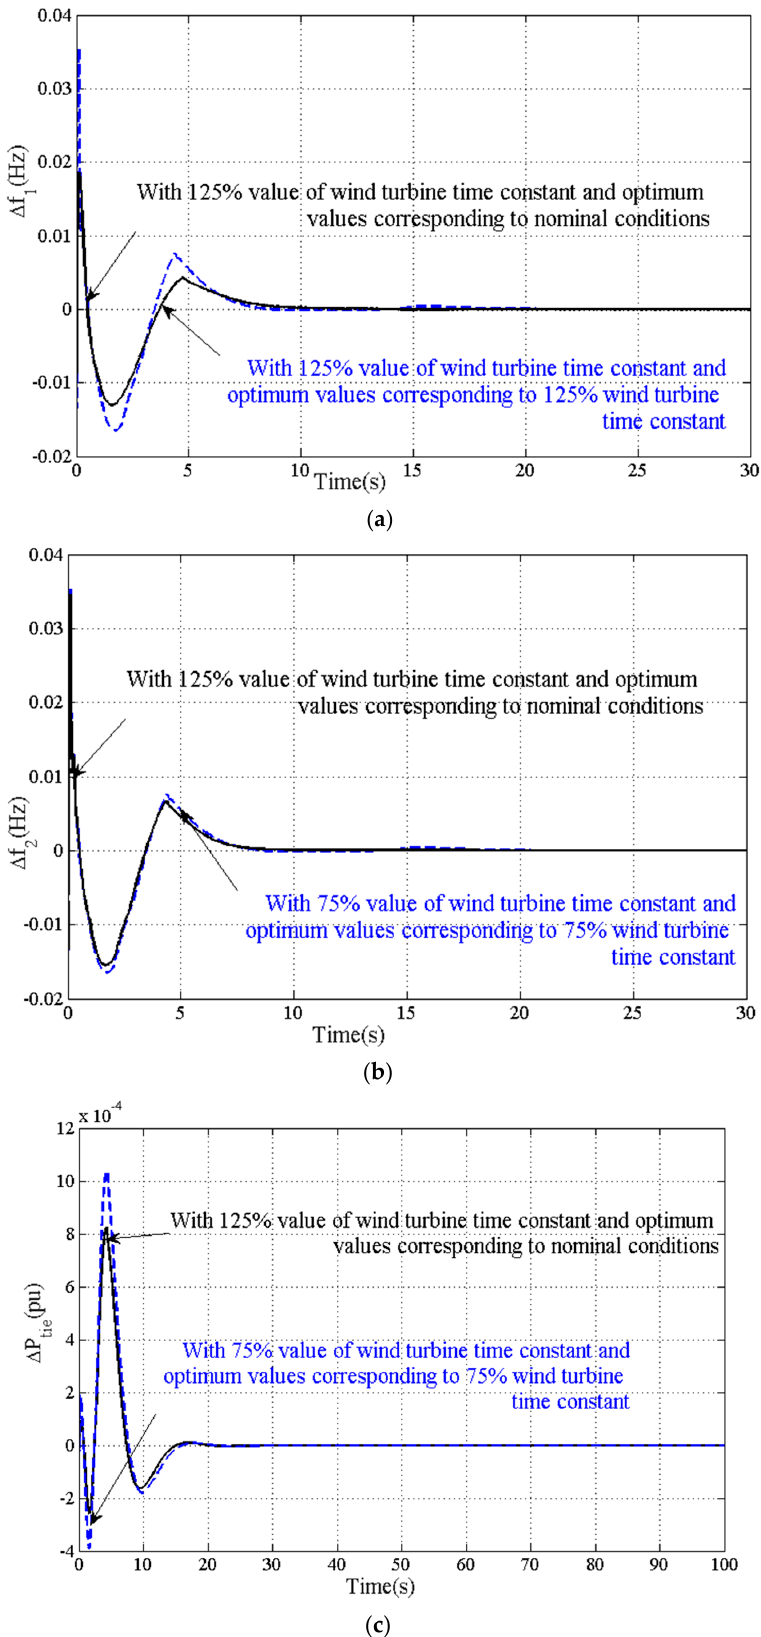
Figure 17. Insensitiveness of PID controller with +25% variations in time constants of WTs. ( a ) ∆ f 1 ; ( b ) ∆ f 2 ; and ( c ) ∆ P tie . ( b ) ∆ f 2 ; and ( c ) ∆ P tie